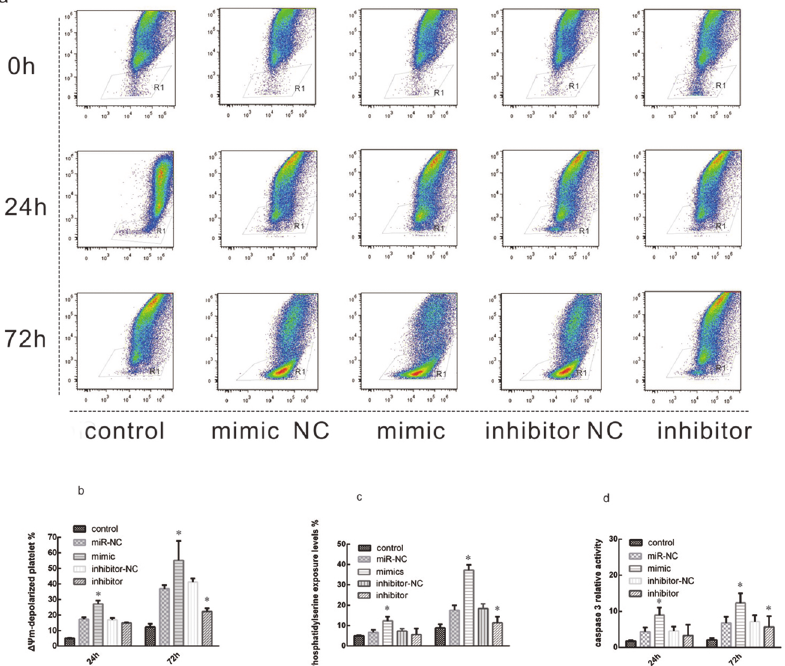
Fig 4. MiR-326 promotes platelet apoptosis. Leukocyte-depleted apheresis platelets (LDPs) were untransfected (control) or transfected with 50 nM of miR-326 mimic or a non-targeting negative control miRNA (miR-NC). LDPs were cultured under standard blood banking conditions and harvested at 24 or 72 h. Flow cytometry was used to analyze the apoptosis status of platelets after transfection. ( a, b ) Depolarization of ΔΨ m was determined by JC-1 fluorochrome assay. * P < 0.05. ( c ) Annexin V positive staining of platelets increased by nearly two-fold after transfection of miR-326 mimic. * P < 0.05. ( d ) Overexpression of miR-326 mimic increased caspase-3 activity in LDP. * P <